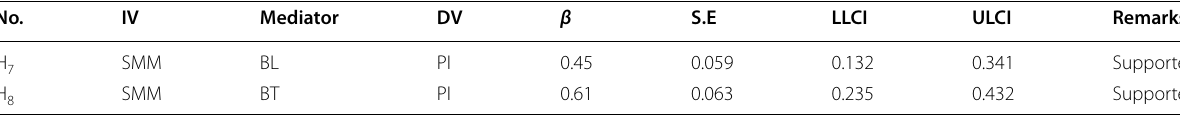
Table 5 Mediation model analysis